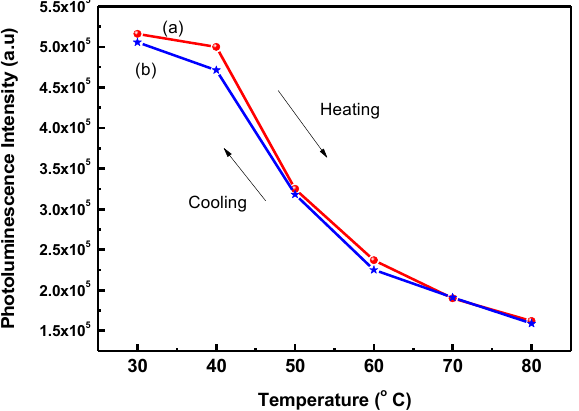
Figure 4. Photoluminescence intensity of POF 10 – b –PDPAEMA 197 in water at a heating–cooling cycle between 30 and 80 °C: ( a ) heating ( b ) cooling.